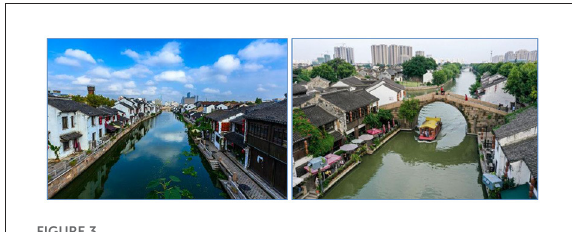
FIGURE3 Street scene of Qingming Bridge historical and cultural